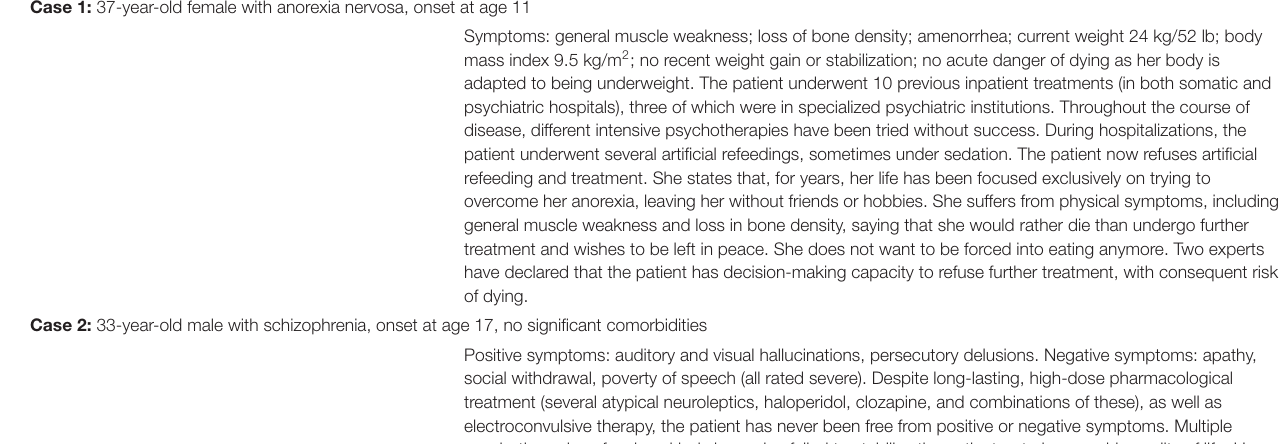
TABLE 2 | Case vignettes. Case 1: 37-year-old female with anorexia nervosa, onset at age